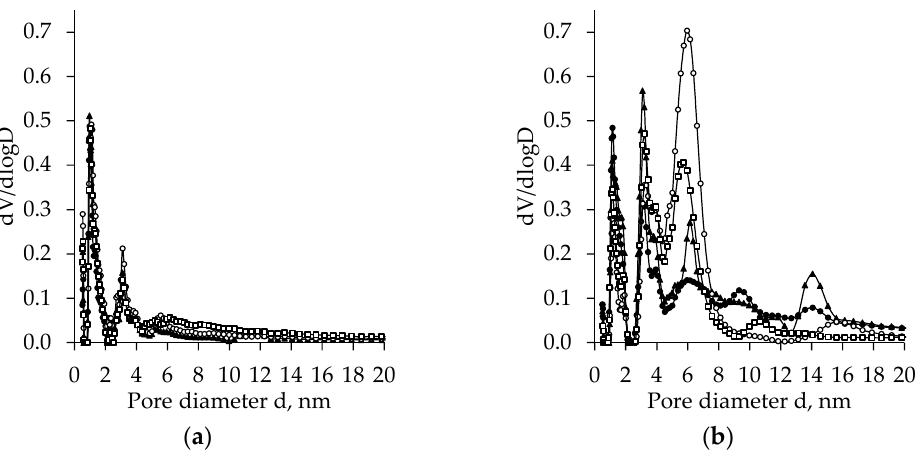
Figure 5. Pore size distribution of the subcritical dried TiO 2 aerogel synthesized using precursor TBOT vs. exchanging solvent type ( –without exchange, –nH, ▲ – cH, –DE)—without ( a ) and after ( b ) ageing.